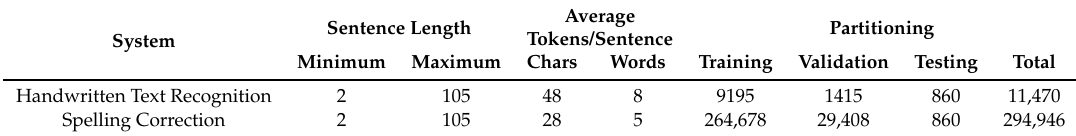
Table 1. Data distribution from Bentham database.